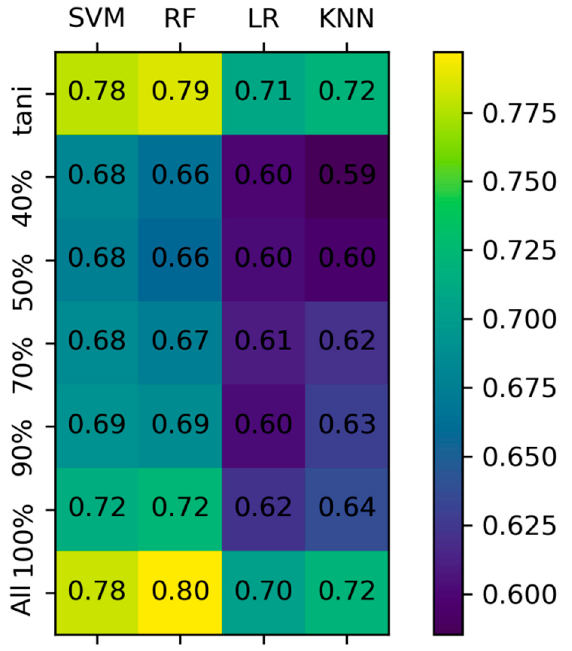
Figure 1. Pearson correlation coefficient of predicted versus experimental binding affinity achieved by different machine-learning models when trained on filtered datasets and tested on the combined test set. The training sets are derived from the PDBBindv2018 general set by applying a filter for sequence identity and ligand similarity. Support vector machine-based regression (SVM), linear regression (LR), random forest (RF) and k-nearest neighbor (KNN).